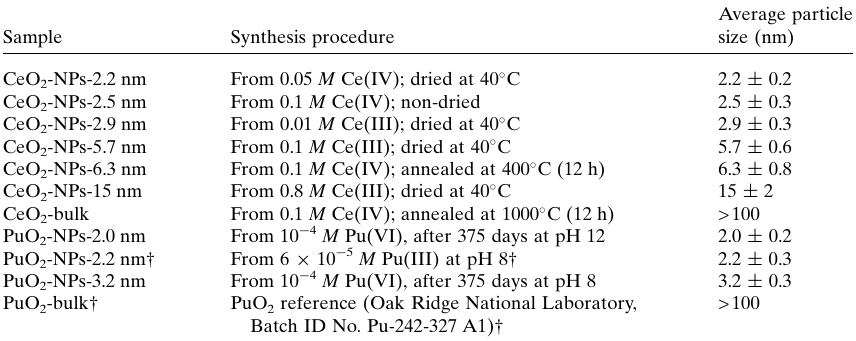
Table 1 List of the studied CeO 2 and PuO 2 samples.